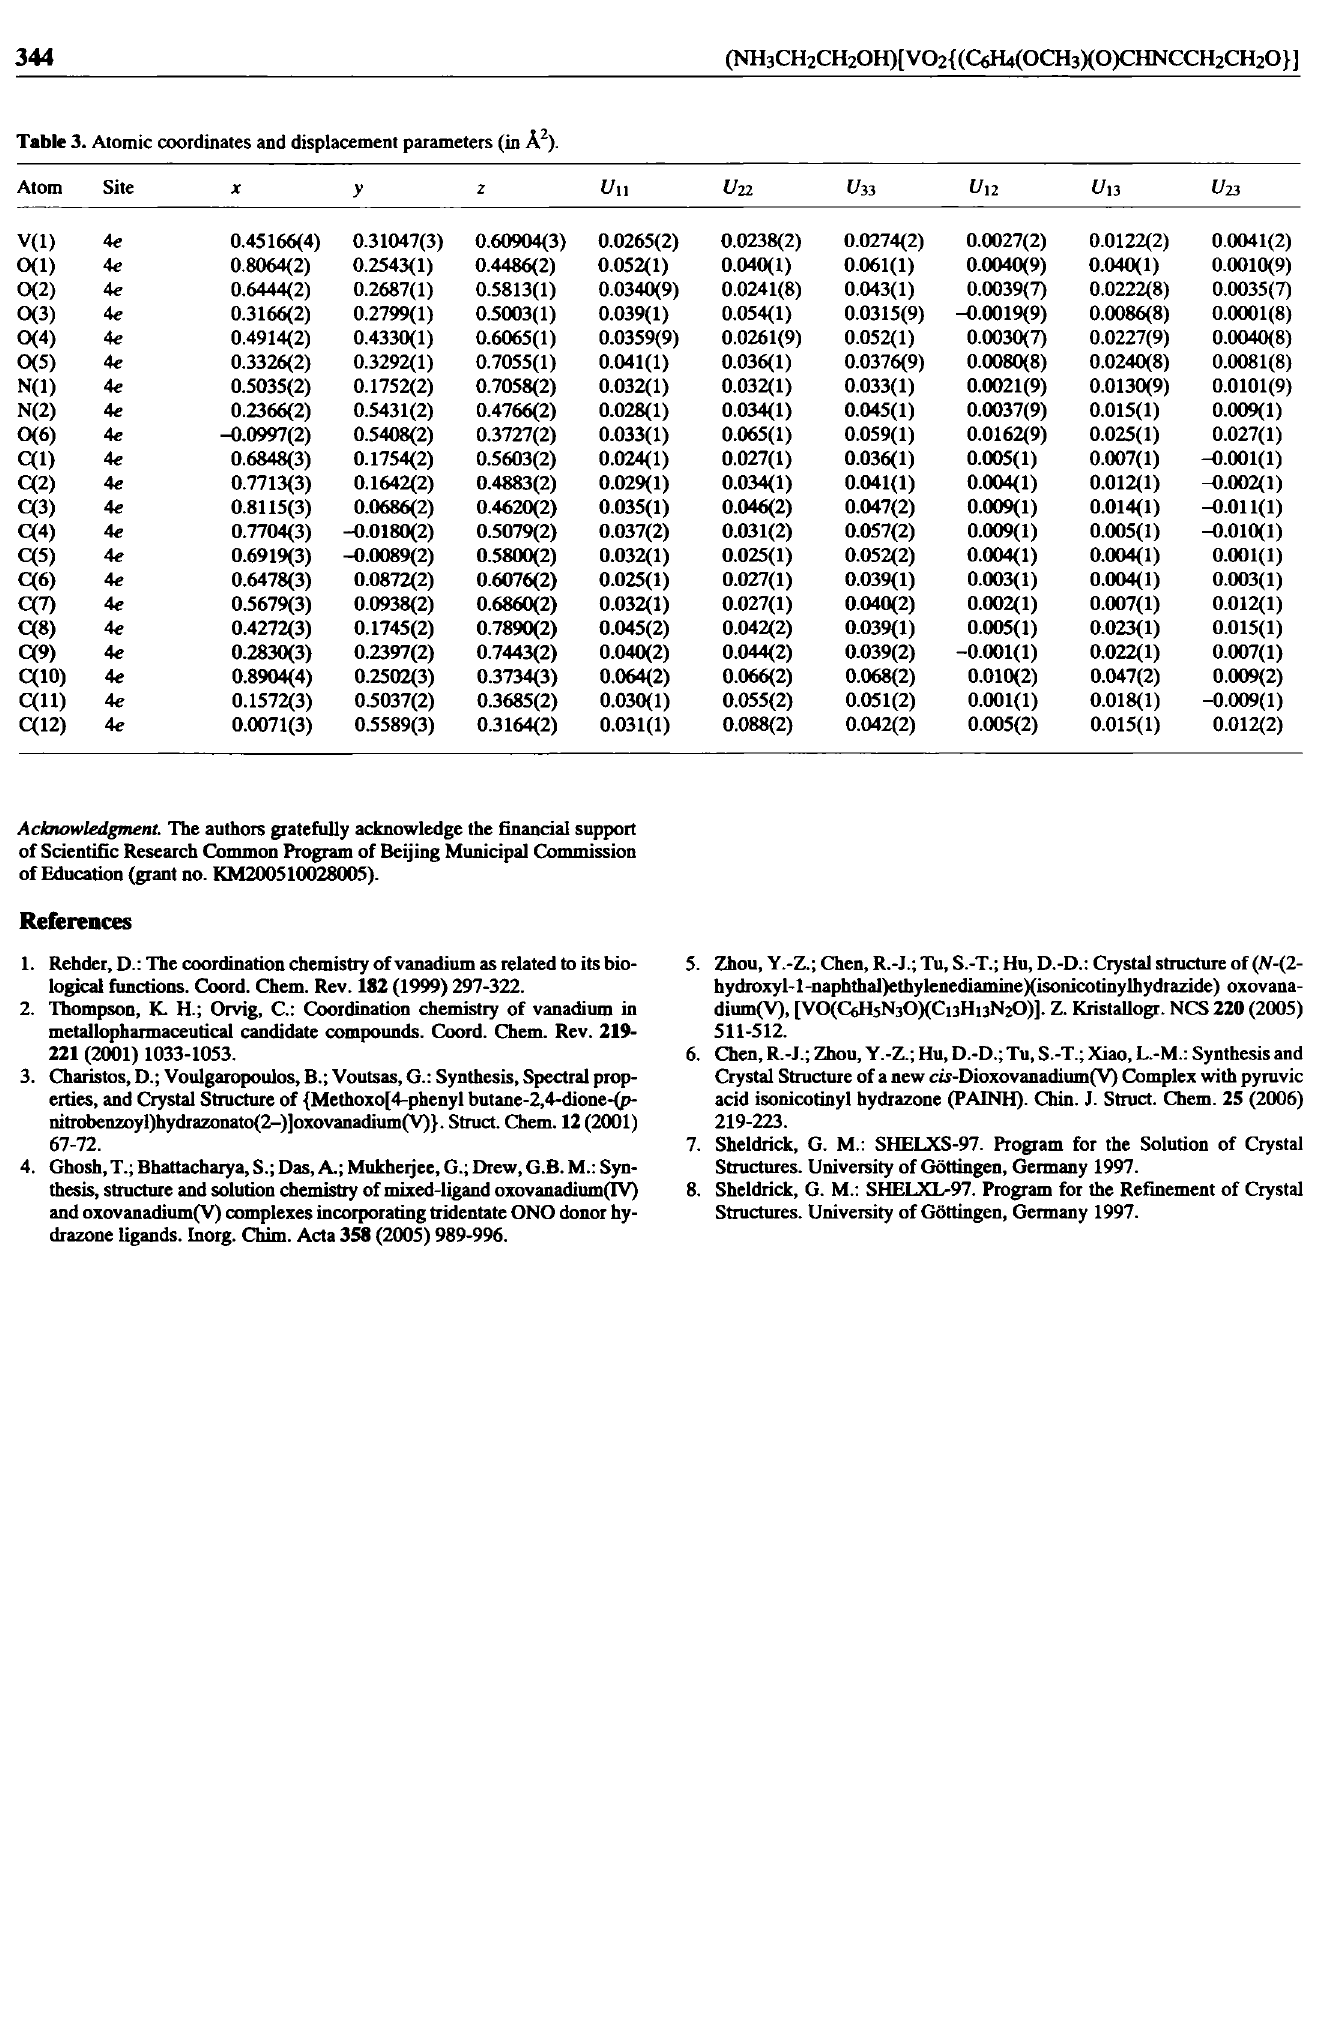
Table 3. Atomic coordinates and displacement parameters (in Ä 2